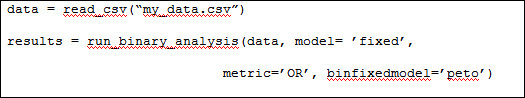
Example call to the back-end from scripting environment.